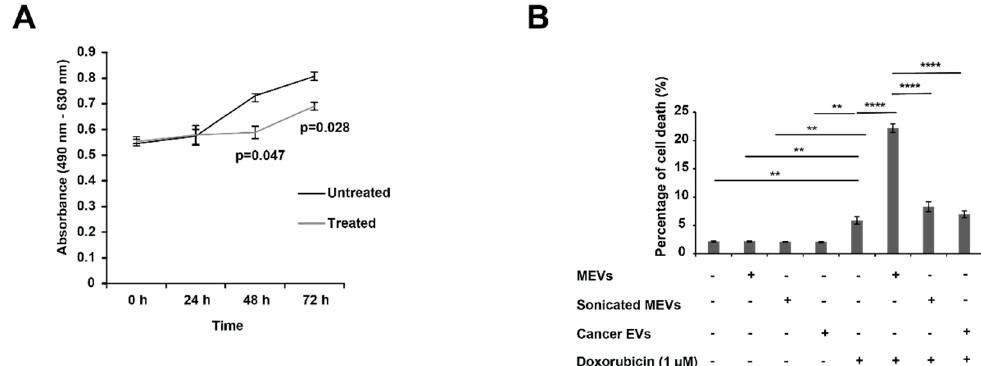
Figure 2. MEVs treatment sensitised aggressive neuroblastoma (NBL) cells to doxorubicin. ( A ) The relative proliferation rate of NBL cells were analysed in the presence and absence of MEVs (100 µg/mL) using MTS assay. ( B ) FACS cell death assay on SK-N-BE2 cells treated with MEVs (100 µg/mL), sonicated MEVs (100 µg/mL), C26 cancer cell-derived EVs (100 µg/mL), doxorubicin (1 µM) or combinatorial therapy. There was a significant increase in percentage of cell death upon the combinational treatment of doxorubicin and MEVs. EVs isolated from cancer cells did not sensitise NBL cells to doxorubicin treatment. Error bars represent the standard error of mean, n = 3, ** denotes the significance of p < 0.01, **** denotes the significance of p < 0.0001 as determined by t -test and one-way analysis of variance (ANOVA) with Turkey–Kramer multiple comparison post-hoc test using GraphPad Prism 8